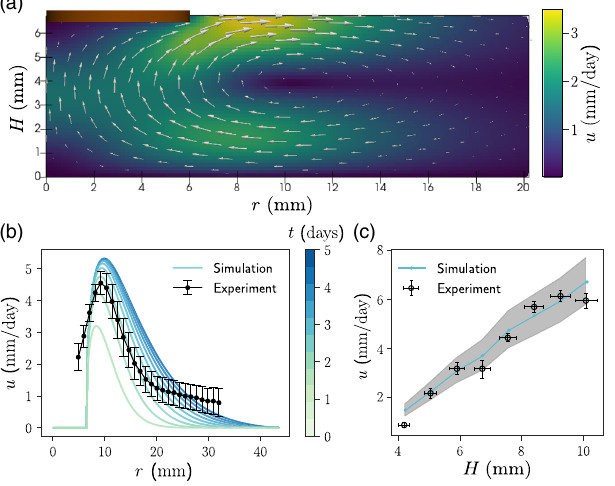
FIG. 6. (a) Snapshot of the simulated flow field below the yeast colony (brown bar) after flow is initiated, for t ≫ t (cid:3) . The simulated flow field qualitatively matches our experiments with a vortex ring produced around the colony. (b) Azimuthal average of the numerical flow field using the measured parameters in Table II plotted every 12 h at the substrate fluid surface. The black circles correspond to the experimental flow radial profile measured for similar flow parameters after 24 h of growth and an initial η ¼ 600 (cid:2) 90 Pa s. (c) Simulated and experimental peak radial velocity determined from PIV measurements 48 h after inocu- lation as a function of fluid height below the colony. The blue line with circles corresponds to the simulated values using the parameters in Table II, the black shaded region is the standard deviation of the simulated points, and the black circles corre- spond to experimental